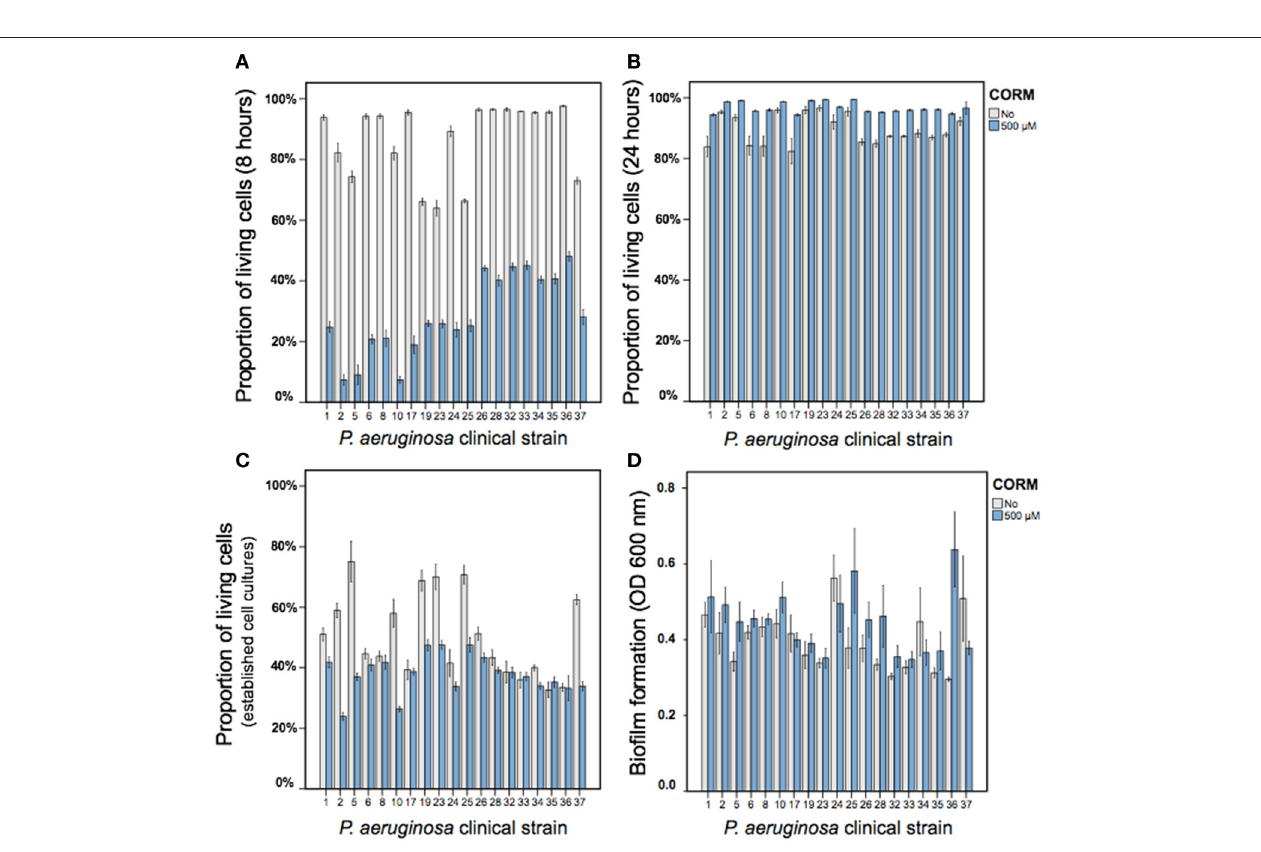
FIGURE 3 | The EBOR-CORM-1 effects on planktonic and biofilm cells of clinical P. aeruginosa CF isolates. (A,B) show the proportion of living cells after 8 and 24h of EBOR-CORM-1 application, respectively. (C,D) show the EBOR-CORM-1 effects on established cell cultures and biofilms, respectively. In all panels, bars denote for ±